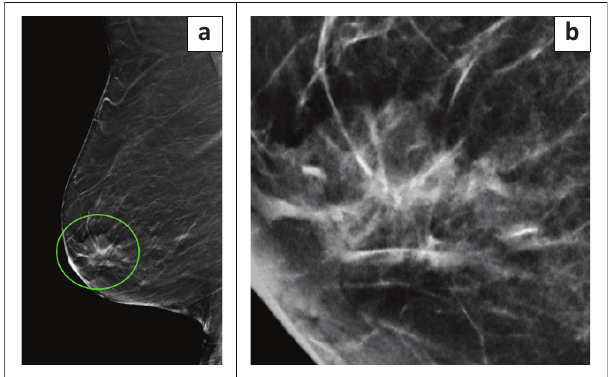
FIGURE 2: A lesion with radiological-pathological discordance based on stereotactic biopsy histology. (a) Mediolateral oblique reconstructed image from digital breast tomosynthesis revealing a spiculated mass in the retroareolar region of the right breast. (b) On close inspection, associated amorphous microcalcifications can be seen. This was categorised as breast imaging reporting and data system 5. Stereotactic histology revealed a fibroepithelial lesion. Wide- local excision after hook-wire placement yielded only benign breast